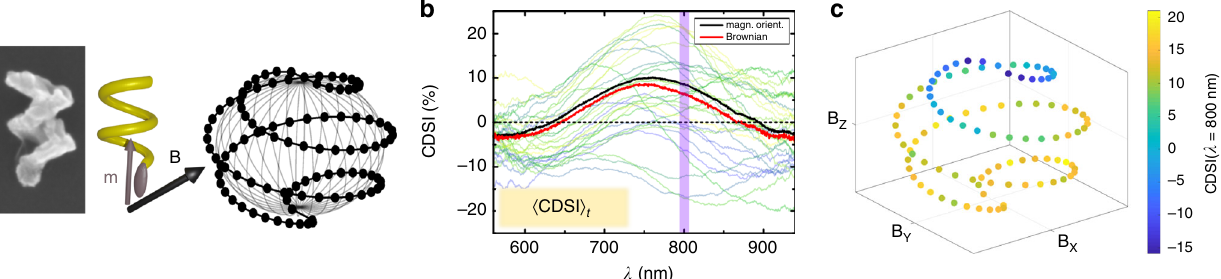
Fig. 4 Chiroptical spectroscopy of an externally controlled single nanohelix. a SEM (scale bar 100 nm) and schematics of an Au nanohelix with magnetic moment m (brown segment at end of helix) that will align with respect to an external magnetic fi eld B (black). Forced sampling of isotropic orientations is achieved by evenly distributing points (black dots) on the surface of a sphere. b 〈 CDSI 〉 t over 10 forced isotropic sampling sequences with i = 100 points (black) and 〈 CDSI 〉 t of the same particle undergoing Brownian motion ( t = 400 frames, red). Thirty randomly selected spectra of individual frames are depicted in the background, whereas the purple vertical line indicates the spectral region shown in ( c ). c CDSI at λ = 800± 5 nm (10 spectra per coordinate) mapped onto the external fi eld